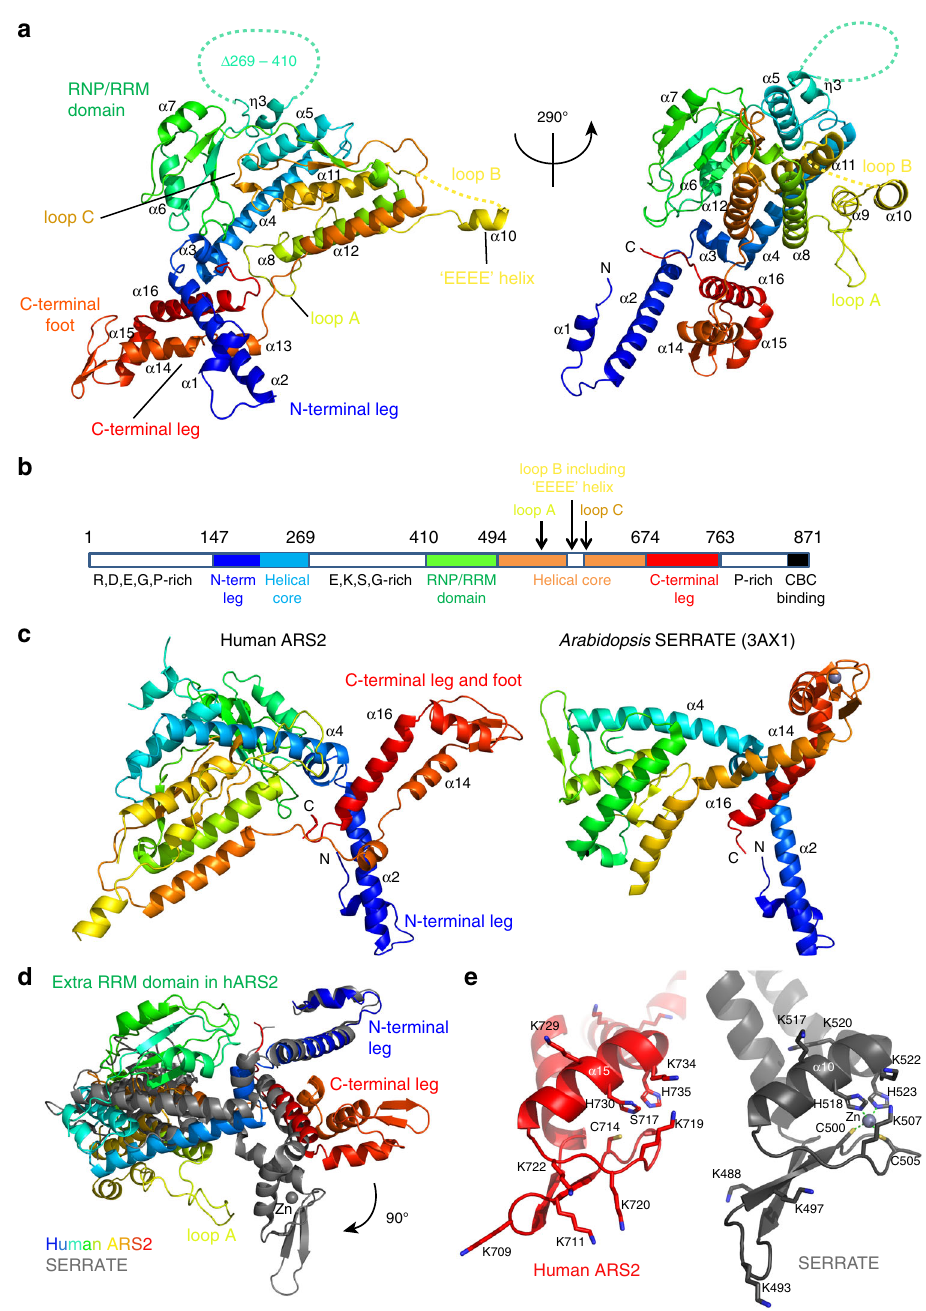
Fig. 1 Crystal structure of human ARS2. a Composite ARS2 147 – 763 model showing loop A (residues 538 – 554) and ‘ EEEE ’ helix from loop B (residues 567 – 599). The structure is rainbow coloured from blue (N-terminus) to red (C-terminus). Dashed lines indicate unobserved or deleted regions. Annotated secondary-structure elements correspond to those on the structure-based alignment (Supplementary Fig. 3). b Schematic diagram showing the ordered regions (coloured) that are separated by unobserved and presumably, intrinsically disordered regions (white) (Supplementary Fig. 1b). c Comparison of human ARS2 (left) and A. thaliana SERRATE (right) crystal structures. Both structures are rainbow coloured as in a . The structures were aligned via the N- terminal helices regions since many of the other elements are differently orientated. A full structural alignment using DALI yields Z = 14.4, RMSD = 9.6 Å for 264 residues aligned with 25% identity. d Superposition of the human ARS2 (rainbow coloured) and SERRATE (grey) structures via their N-terminal regions, as in c . The 90° difference in the orientation of the C-terminal foot is highlighted. The grey sphere in the SERRATE structure is a zinc ion. e Differences between the C-terminal foot of metazoan ARS2 (left, red) and plant SERRATE (right, grey) shown in the same orientation. Key lysine residues are indicated, as well as the two cysteines (C500, C505) and two histidines (H518, H523) that co-ordinate the zinc ion (grey sphere) in SERRATE. In human ARS2, the equivalent of C505 is S717 and no zinc ion is